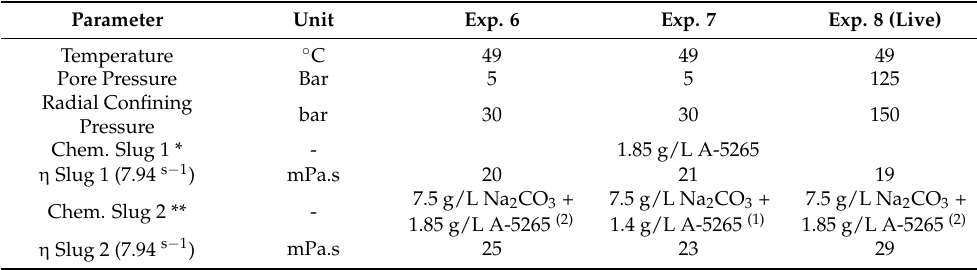
Table 5. Summary of parameters for sand pack flood experiments performed in this work. Core orientation was vertical and injection rate was 1